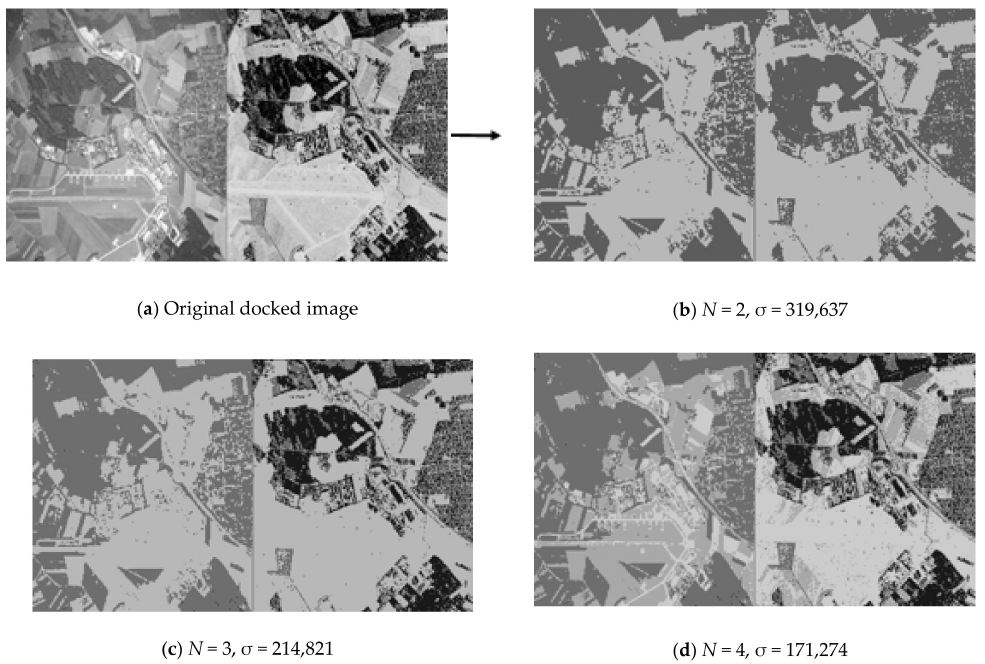
Figure 4. Part of a series of partitions of the docked optical and radar images into pixel clusters by means of multi-threshold